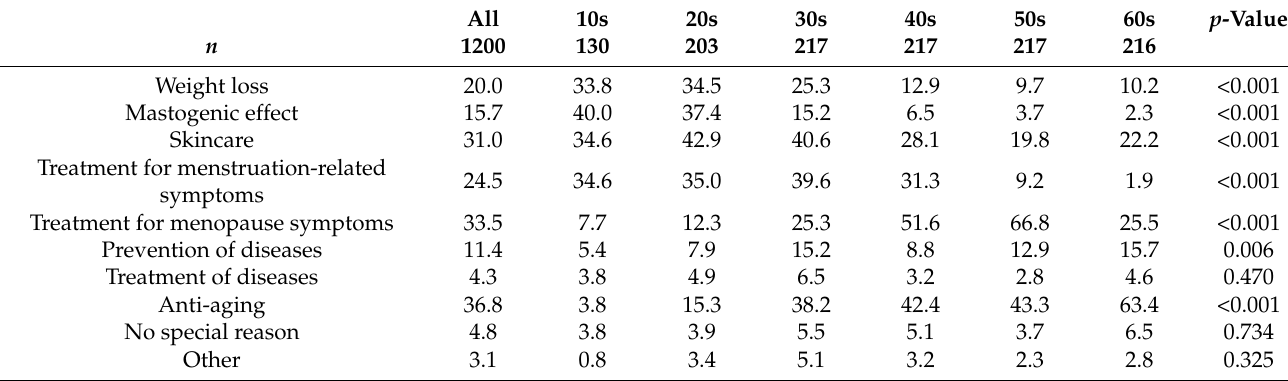
Table 7. The purpose of estrogen-like supplement use.